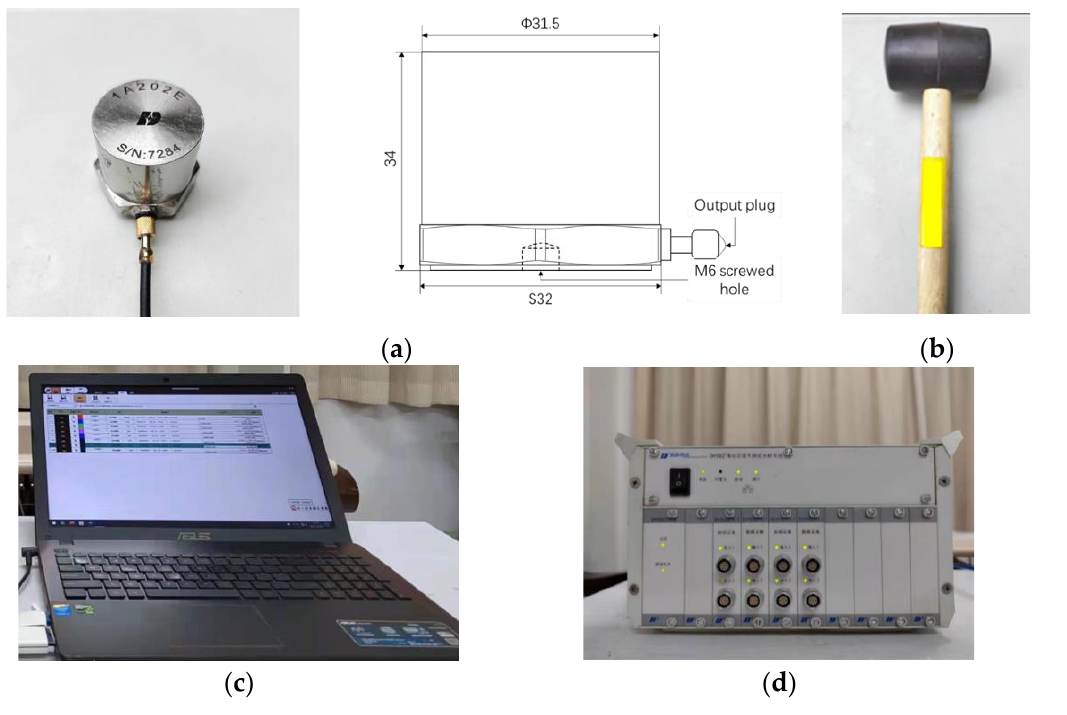
Figure 13. Experimental facilities: ( a ) Piezoelectric acceleration sensor. ( b ) Rubber hammer. ( c ) Laptop. ( d ) DH5927N dynamic signal test and analysis system.